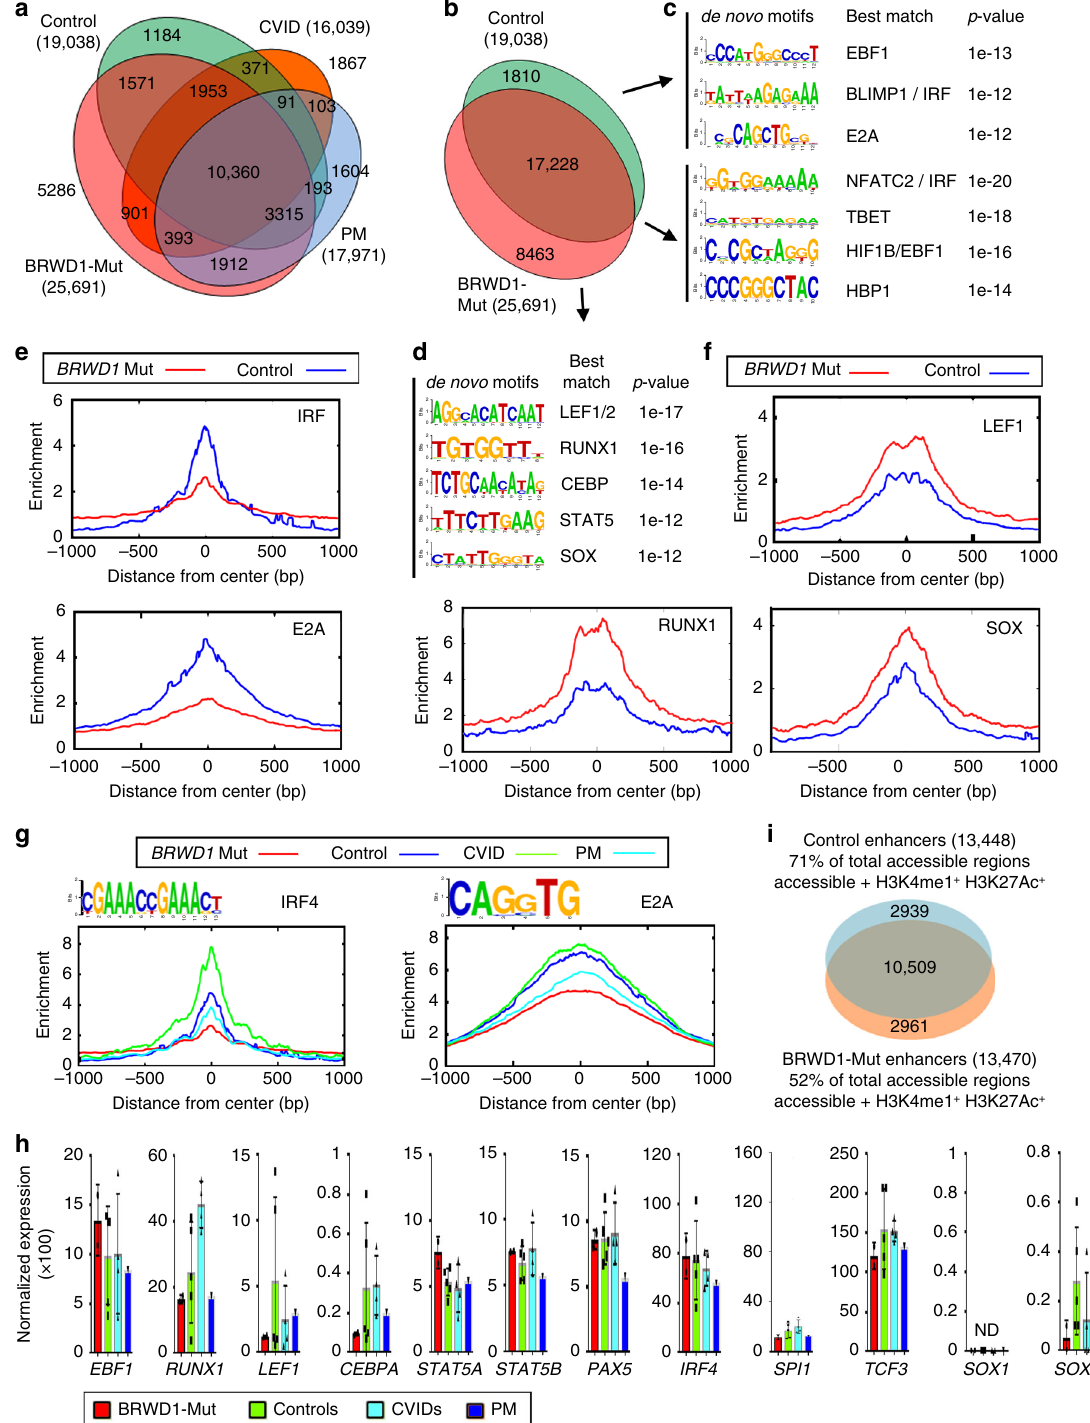
Fig. 7 Human BRWD1 determines the genomic targets accessible to TFs. a Overlap of open chromatin peaks (ATAC-Seq) in EBV-transformed cells of patient group (P1 and P2), control group (C1-5), unrelated common variable immunode fi ciency group (CVID1-4) and patients ’ mother (PM). b Overlap of open chromatin peaks (ATAC-Seq) in cells from indicated populations. For ( a ) and ( b ) total number of peaks for each population shown in parentheses with number in each Venn region indicated. c , d De novo DNA sequence motifs enriched in indicated areas of Venn diagram. e , f Average accessibility at transcription factors IRF4 and E2A ( e ) and LEF1, RUNX1 and SOX ( f ). Accessibility at indicated binding sites for patients (red) and control (blue) cells. g Average accessibility of IRF4 and E2A transcription factor binding sites in open chromatin regions of all the groups described in ( a ). h Quantitative normalized mRNA expression of transcription factors EBF1, RUNX1, LEF1, CEBPA, STAT5A, STAT5B, PAX5, IRF4, SPI1 (PU.1), TCF3 (E2A), SOX1, SOX2 and SOX3 in EBV-transformed cells of BRWD1 -mut hypogammaglobulinemia patients (P1 and P2), controls (C1-5), unrelated common variable immunode fi ciency patients (CVID1-4) and PM along with Individual expression. Data are presented as average ± s.d. ( n = 2). i Comparison of accessible enhancers (open chromatin + H3K4me1 + H3K27Ac + ) between controls and BRWD1 -Mut patients